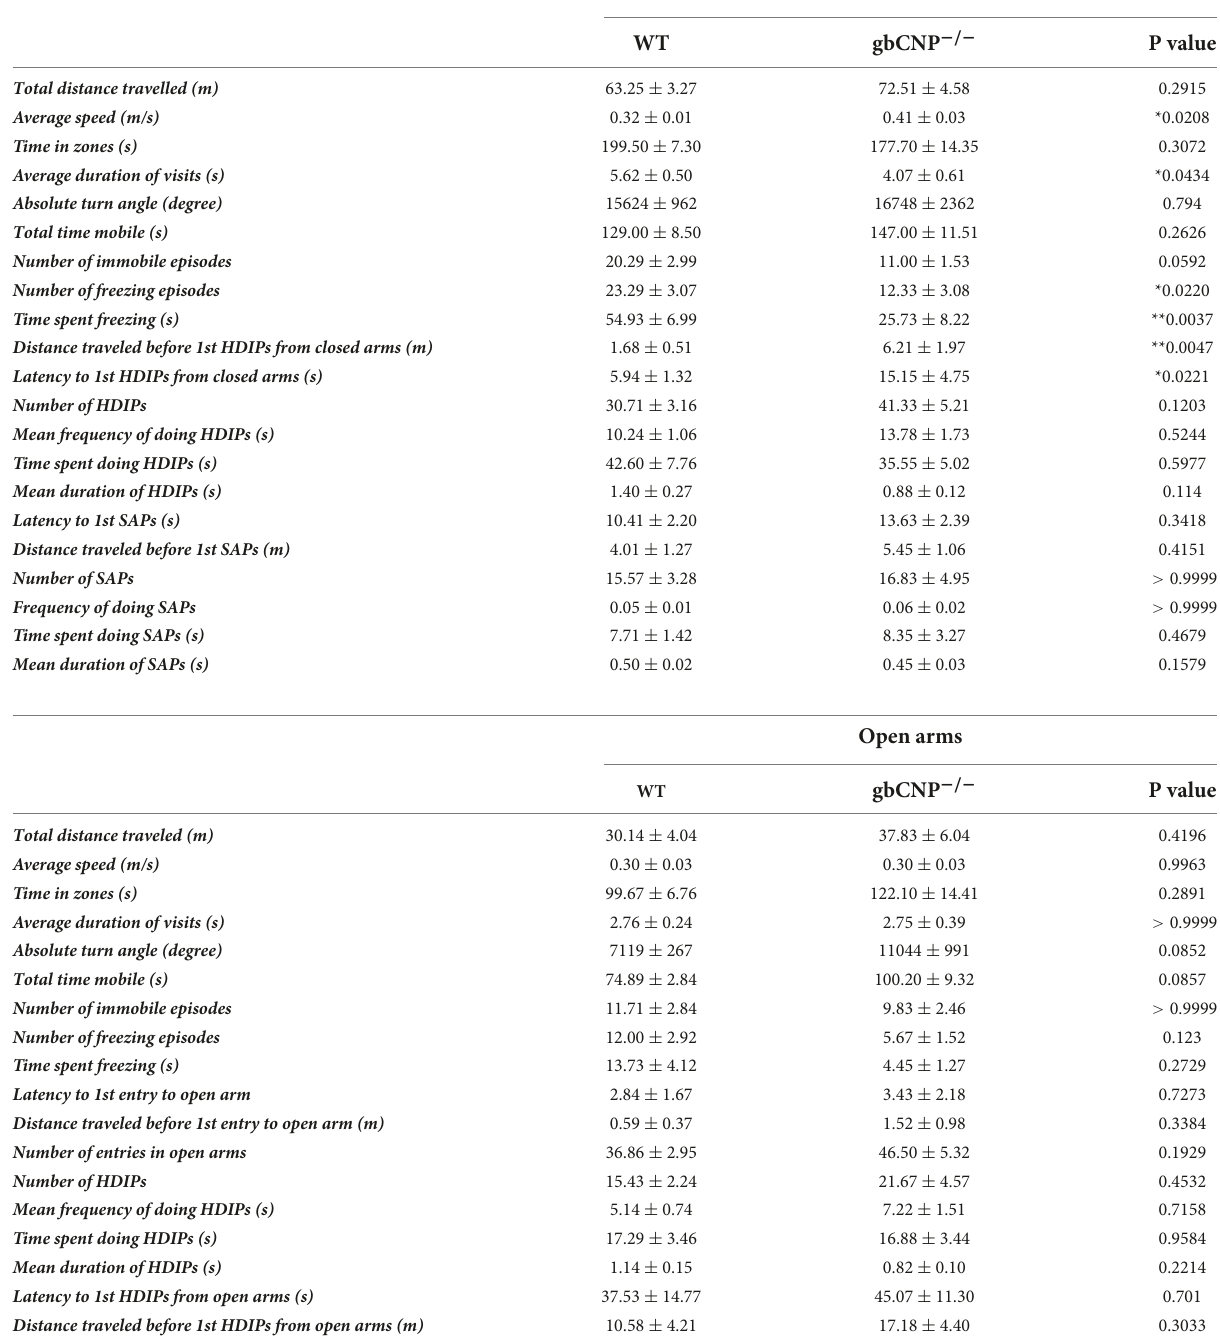
TABLE 4 Elevated zero maze behavior in wild-type and global CNP knockout